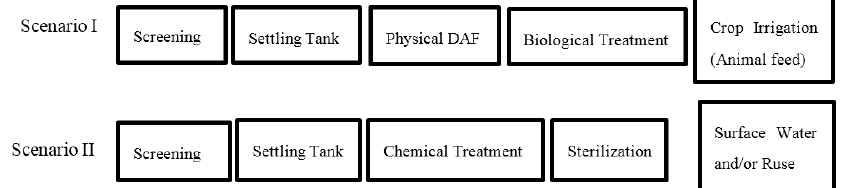
Figure 4. Scenarios for wastewater treatment from slaughterhouses.